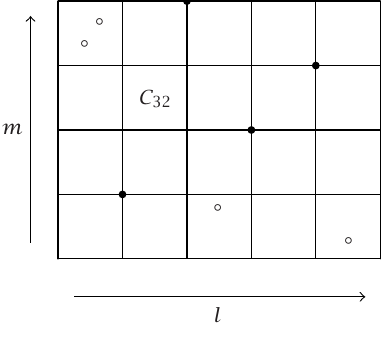
Figure 2.1 . Kernel cell decomposition for π = 67382451 ∈ S ( 1423 )